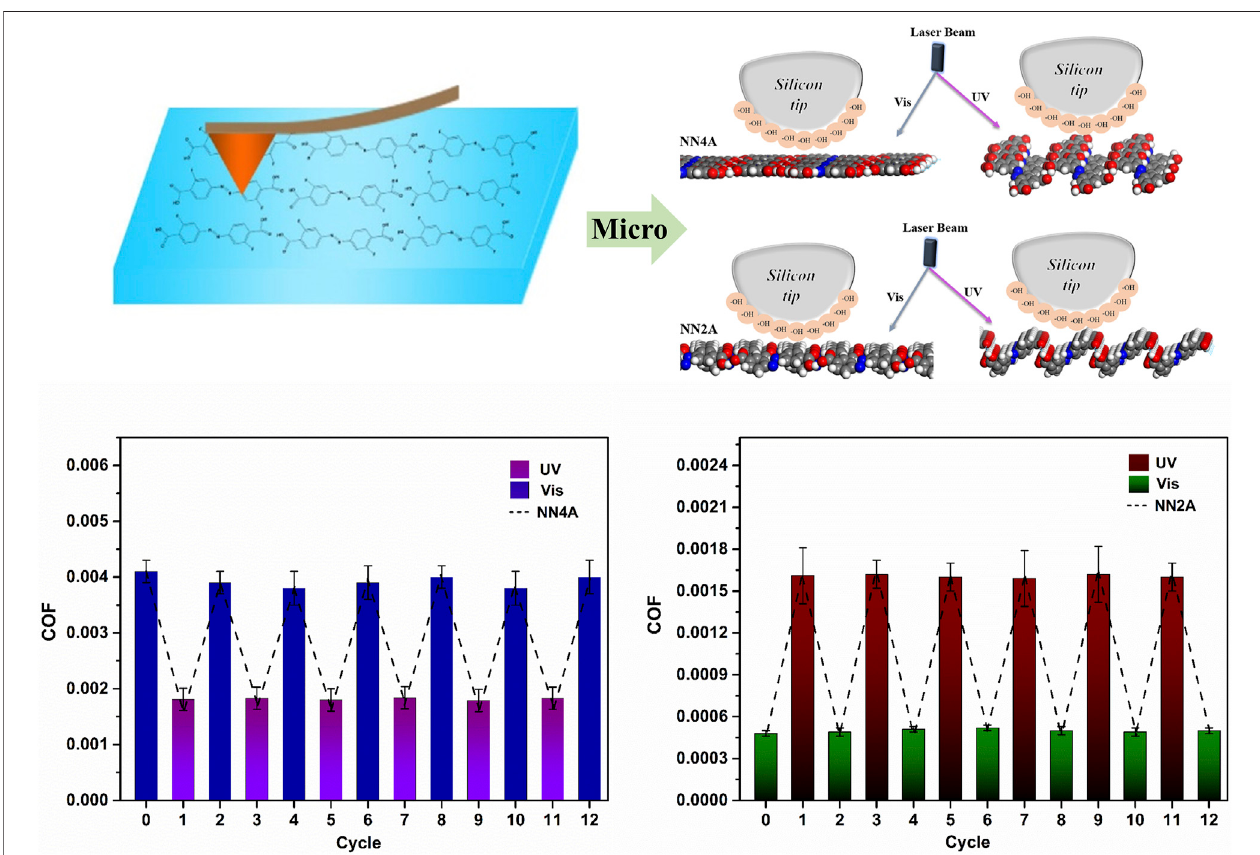
FIGURE 5 | The comprehensive graphic